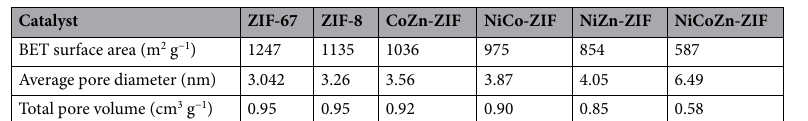
Table 2. BET surface area, average pore diameter, and the total pore volume of ZIF-67, ZIF-8, CoZn-ZIF, NiCo-ZIF, NiZn-ZIF and NiCoZn-ZIF.